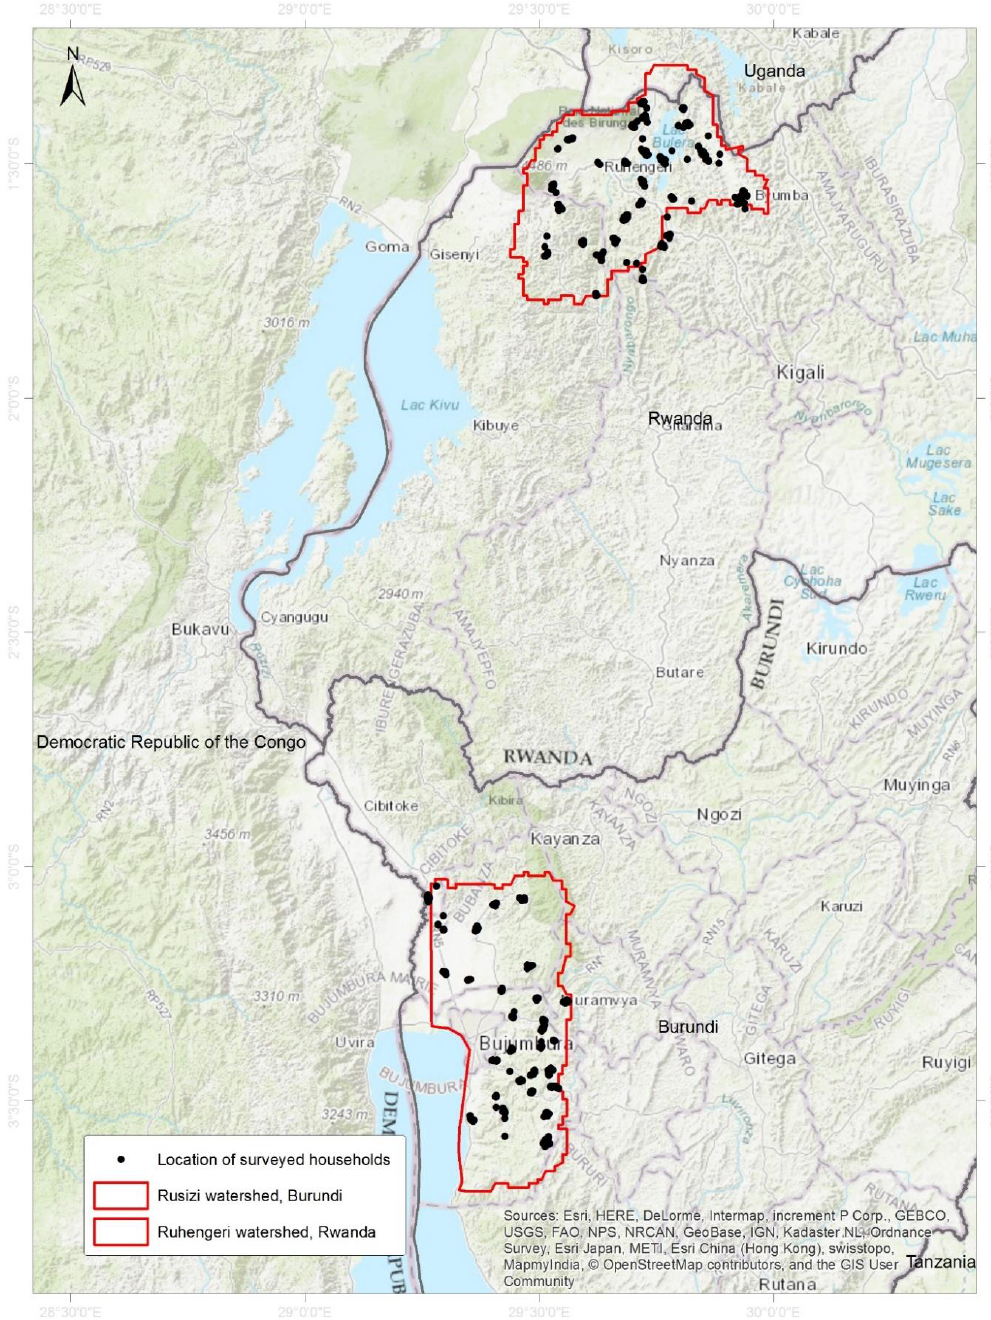
Figure 1. Map of Rwanda and Burundi showing the location of the watersheds and surveyed households